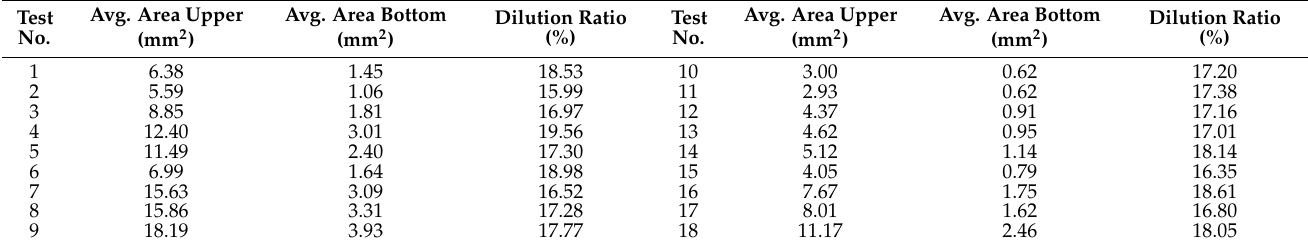
Figure 6. Optical microscope for dilution ratio measurement. Table 7. Results of dilution ratio for fiber laser welding.